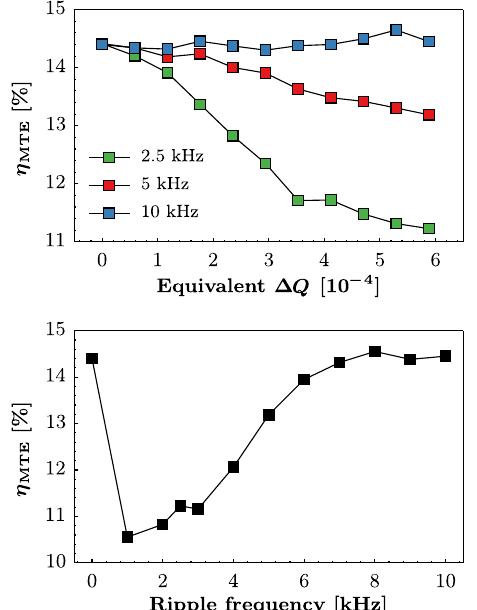
FIG. 12. Dependency of the splitting efficiency on the ampli- tude (top) and frequency (bottom) of the external perturbation. The ripple amplitude is expressed in terms of the amplitude of the sinusoidal perturbation of the horizontal tune. A low-frequency ripple significantly perturbs the splitting